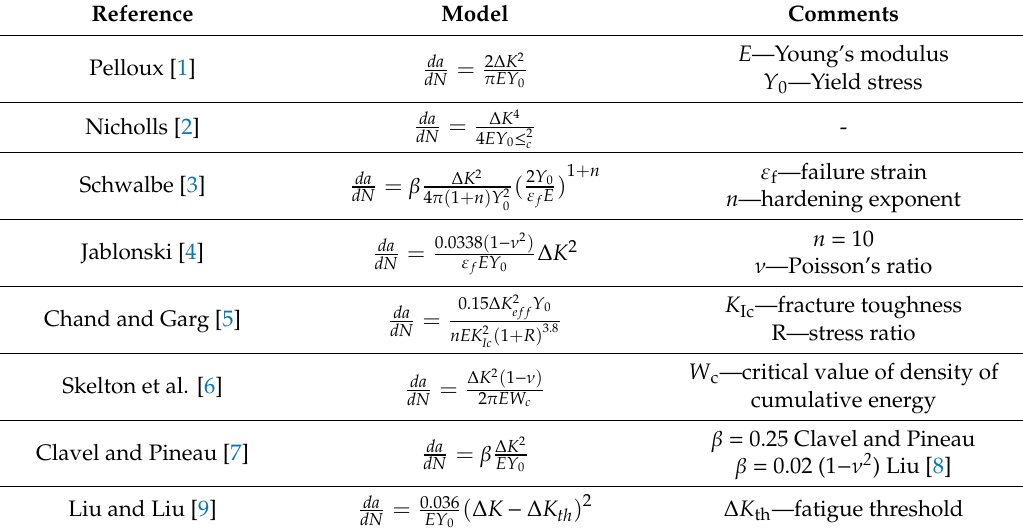
Table 1. Fatigue crack growth models that include material